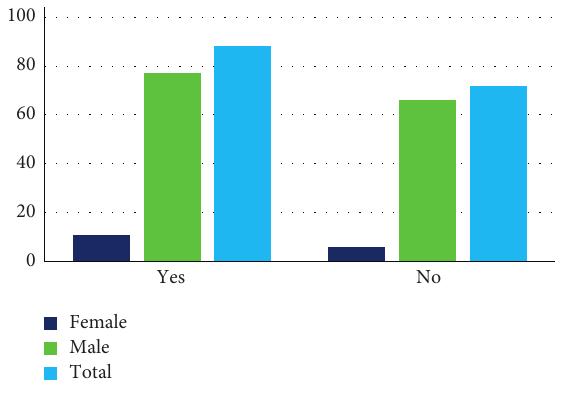
Figure 3: Youth participation.